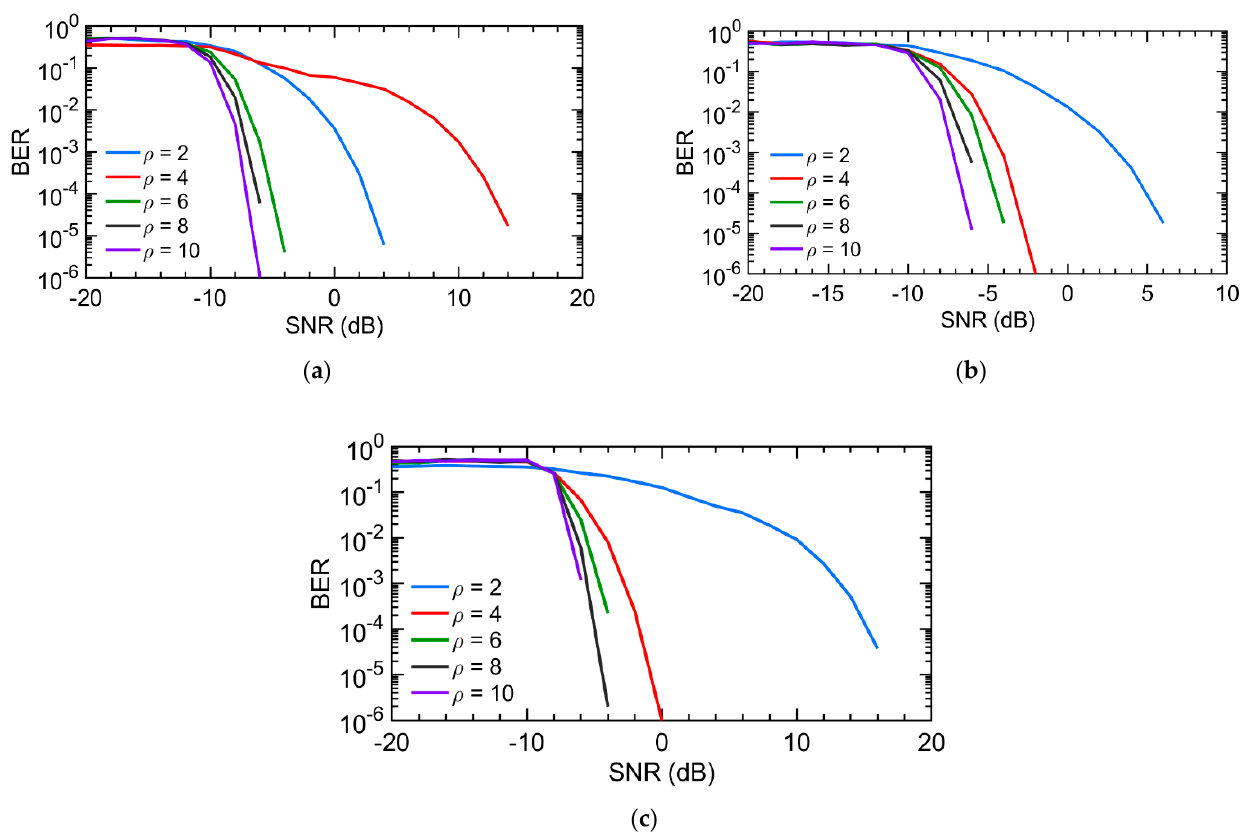
Figure 5. Bit-error-rate (BER): ( a ) 0 ≤ 𝜃 ≤ 𝜋 & 0 ≤ 𝜙 ≤ 2𝜋. ( b ) 0 ≤ 𝜃 ≤ 𝜋/2 & 0 ≤ 𝜙 ≤ 2𝜋 . ( c ) 0 ≤ 𝜃 ≤ 𝜋/8 & 0 ≤ 𝜙 ≤ 𝜋/8 .